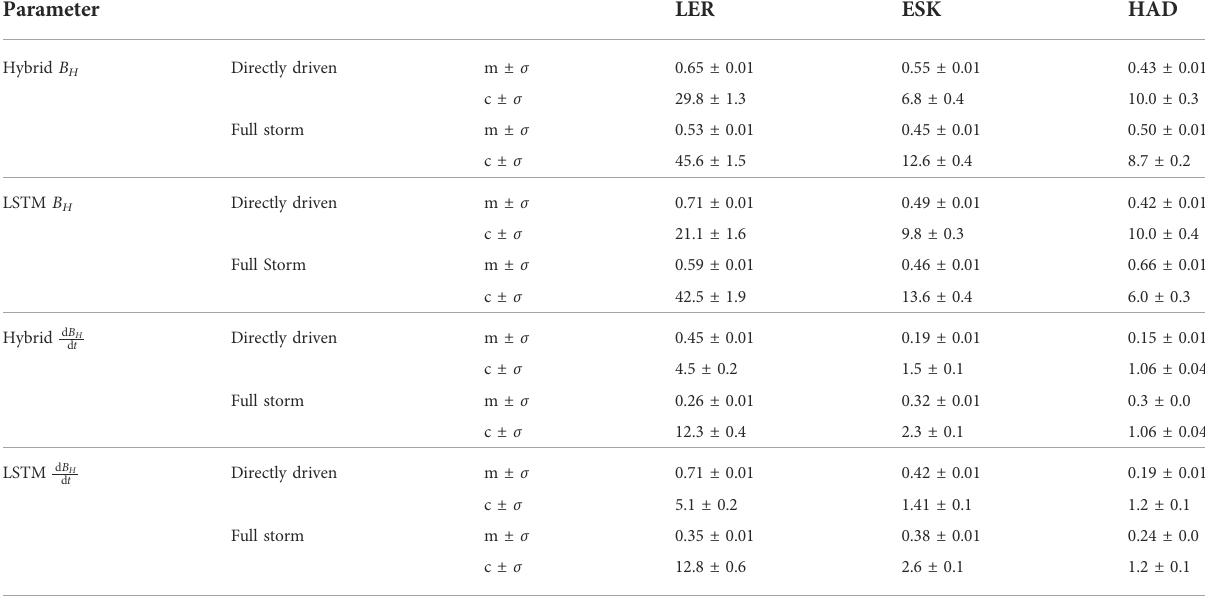
TABLE 3 Gradient, m , and intercept, c , for best fi t lines ofform y = mx + c for 30 minforecast shown in Figure 4. σ is the standarddeviationof the best fi t gradient and intercept parameters derived from the covariance matrix of the least squares fi t. Parameter LER ESK